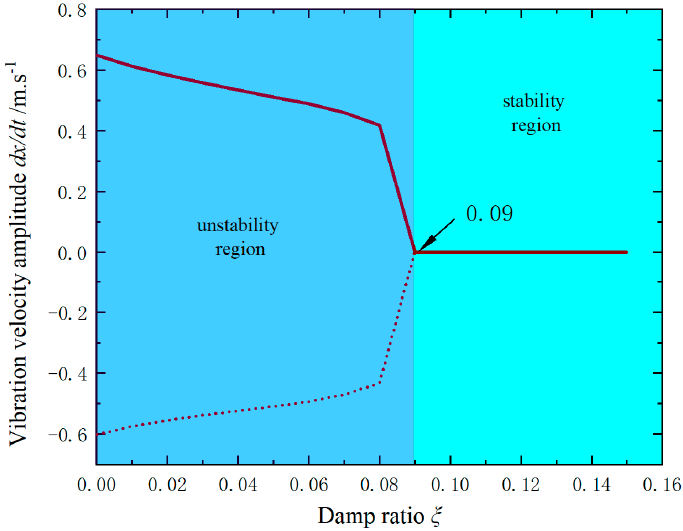
Figure 9. Bifurcation diagram of the system with the damping ratio.